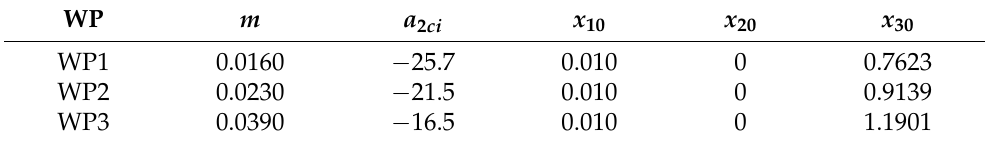
Table 2. Parameters of continuous-time model matrices (30) for 3 working points.